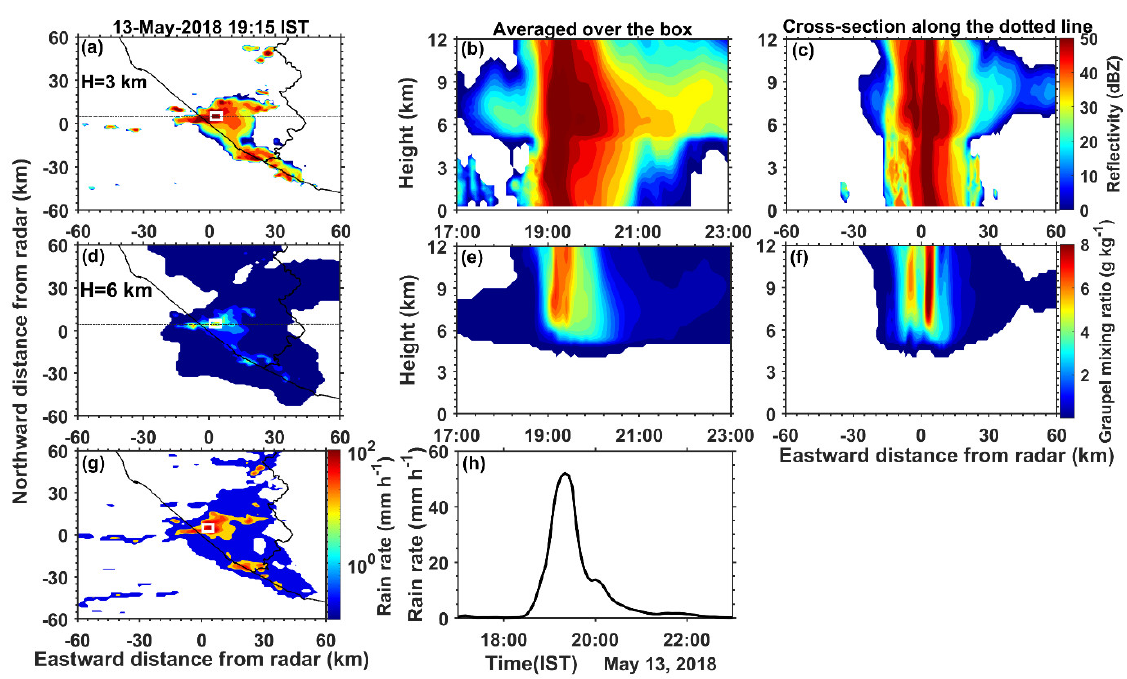
Figure 12. ( a – c ) WRF model simulated reflectivity—( a ) at 3 km height, ( b ) east–west vertical cross section along the horizontal dotted line at 19:15 IST and ( c ) time–height cross section of reflectivity averaged over the white box area. ( d – f ) Simulated graupel mixing ratio—( d ) at 6 km height, ( e , f ) same as in panel ( b , c ), but for graupel mixing ratio. ( g , h ) Simulated rainfall—( g ) rain rate at 19:15 IST and ( b ) time series of the rain rate averaged over the white box area.